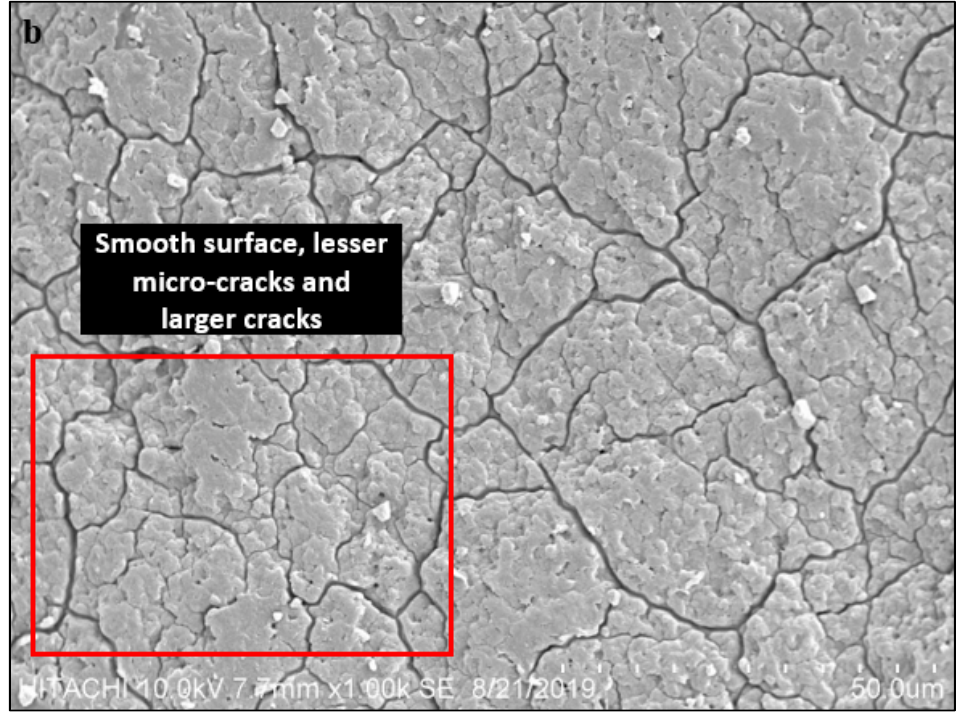
Figure 10. SEM of 4% NaOH treated rubber surface morphology.